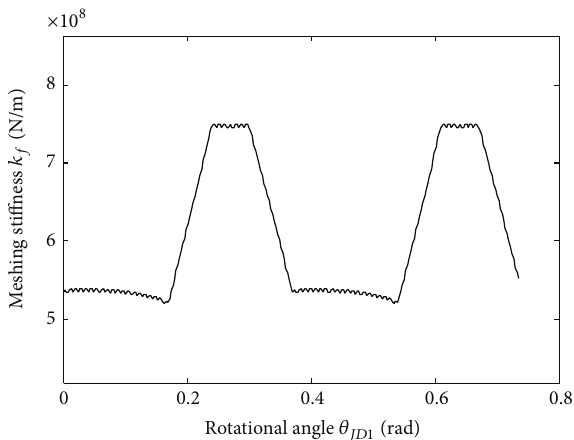
Figure 14: The meshing stiffness of final drive gear